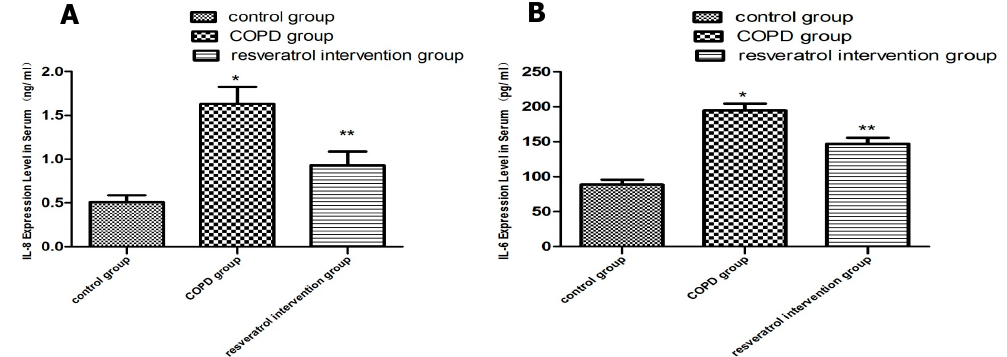
Figure 3. Effects of resveratrol on inflammation in COPD rats. Enzyme–linked immunosorbent assay (ELISA) was performed to detect levels of IL-6 and IL-8 in serums ( A , B ) resveratrol can reduce the levels of IL-6 and IL-8 (n = 10). * p < 0.05, vs. Control group (n = 10); ** p < 0.05, vs. COPD group (n = 10).